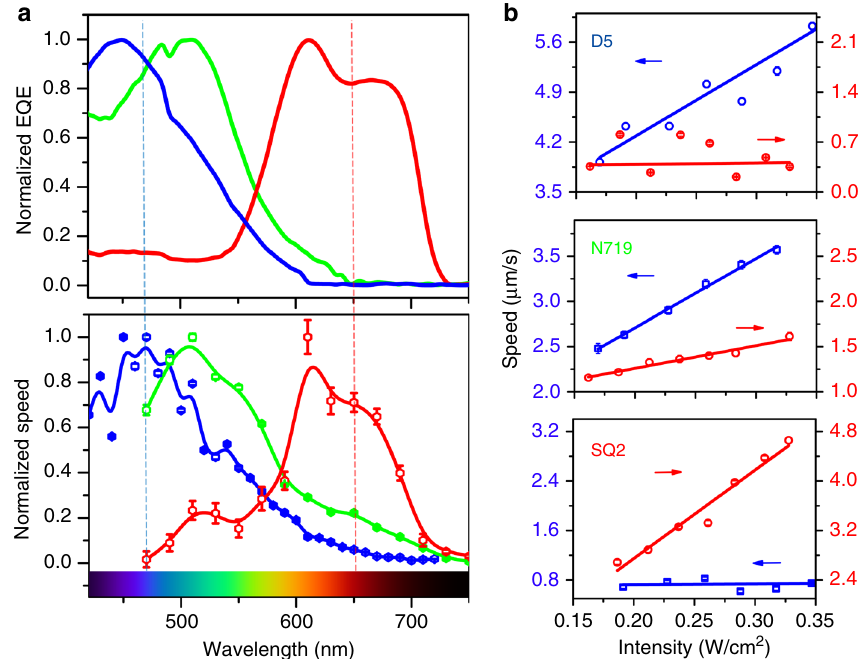
Fig. 2 The spectral response of the dye-sensitized microswimmers. a The normalized EQE of the nanowire-based dye-sensitized solar cells (D5 (blue), N719 (green) and SQ2 (red)) compared with normalized spectral response of the corresponding dye-sensitized microswimmers. The vertical blue and red line indicated the illumination wavelength in b . b The absolute migration speed scales linearly with the illumination intensity of its corresponding absorbed light for various dye-sensitized microswimmers: D5, N719 and SQ2,